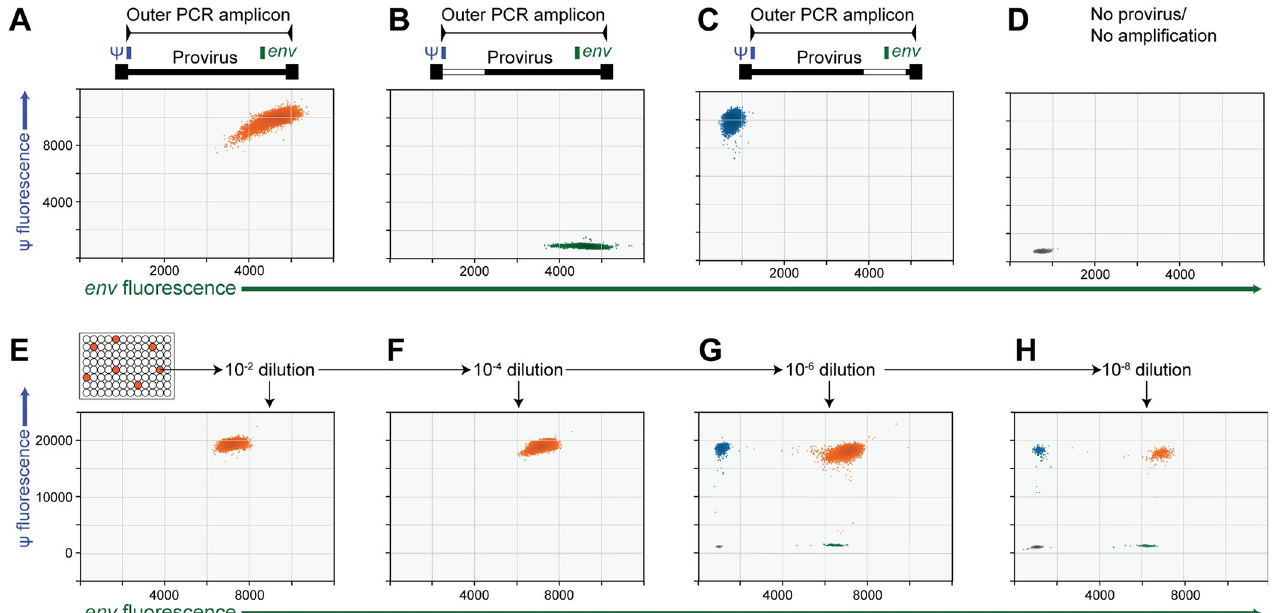
Fig 1. Use of the IPDA to evaluate PCR efficiency in nFGS methods. ( A-D ) IPDA analysis of PCR products from the outer PCR used in all nFGS methods ( S1 Table ). Template was DNA from a treated PLWH diluted to limit dilution with respect to proviruses. Each IPDA dot plot is shown below a diagram illustrating a possible proviral structure that would give rise to the observed plot. ( A ) Exponential amplification of an intact provirus. Each of the ~20,000 droplets in the reaction is positive for both the ψ and env amplicons. As a result, negative droplets which normally appear in the lower left quadrant are absent. ( B ) Exponential amplification of a provirus lacking the targeted psi sequence, for example due to a deletion such as that shown in the white box. ( C ) Representative well in which there was exponential amplification of a provirus lacking the targeted env sequence. ( D ) Representative negative well. ( E-H ) Use of the IPDA to quantitate molecular yields in nFGS methods. Positive PCRs from outer or nested reactions in nFGS methods are serially diluted until most droplets are negative. In this example, DNA from the J-Lat 6.3 clone was plated at limit dilution with respect to proviruses and amplified with the outer and nested PCRs of Method 4. An aliquot from a positive well was serially diluted and reanalyzed by IPDA. With more dilution, negative wells become dominant, allowing digital counting of PCR products as double positive droplets. Some shearing between IPDA amplicons is also evident in the form of single positive droplets at higher